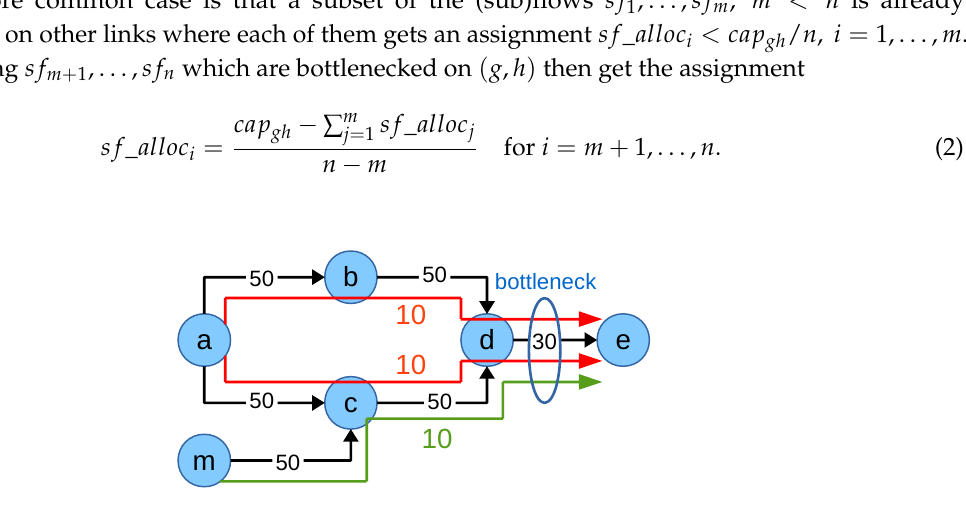
Figure 2. Example for bottleneck subflow fair allocation. Blue circles: nodes; black arrows/numbers: links with capacities; colored arrows/numbers: flows with capacity assignments. All numerical values are given in